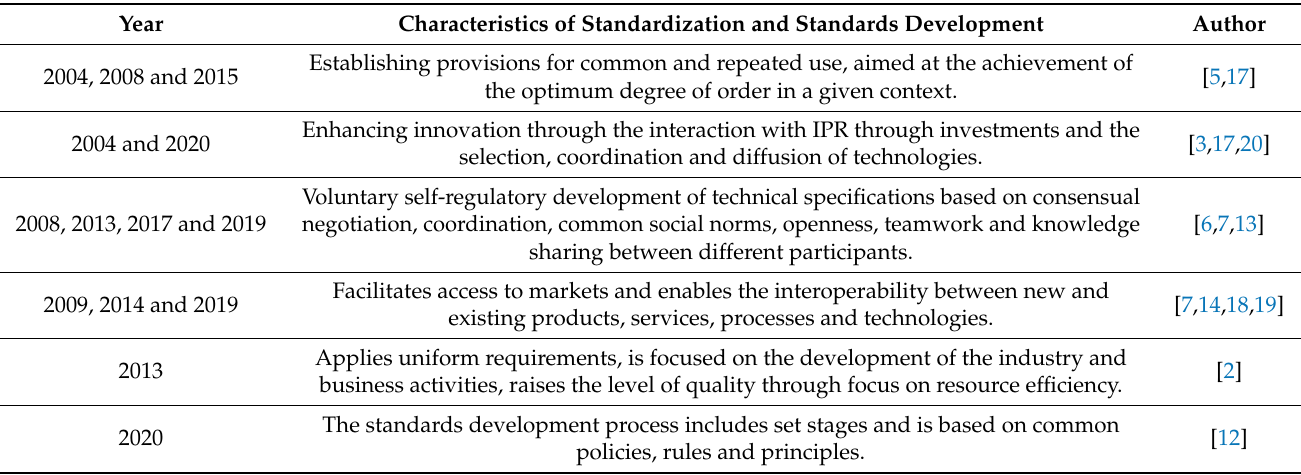
Table 1. The characteristics of standardization and standards